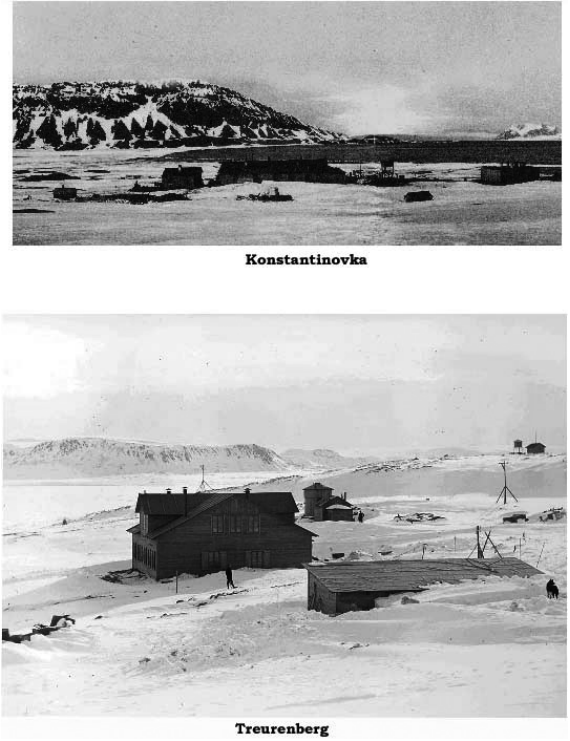
Fig. 3. Above: The Russian expedition base Konstantinovka in Hornsund, Goose Bay. Below: The Swedish expedition base at Treurenberg Bay.